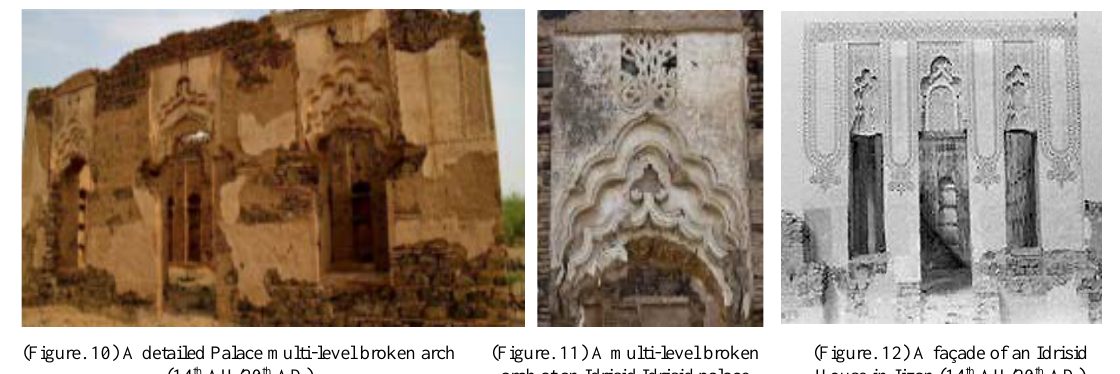
(Figure. 10) A detailed Palace multi-level broken arch (14 th AH/20 th AD)